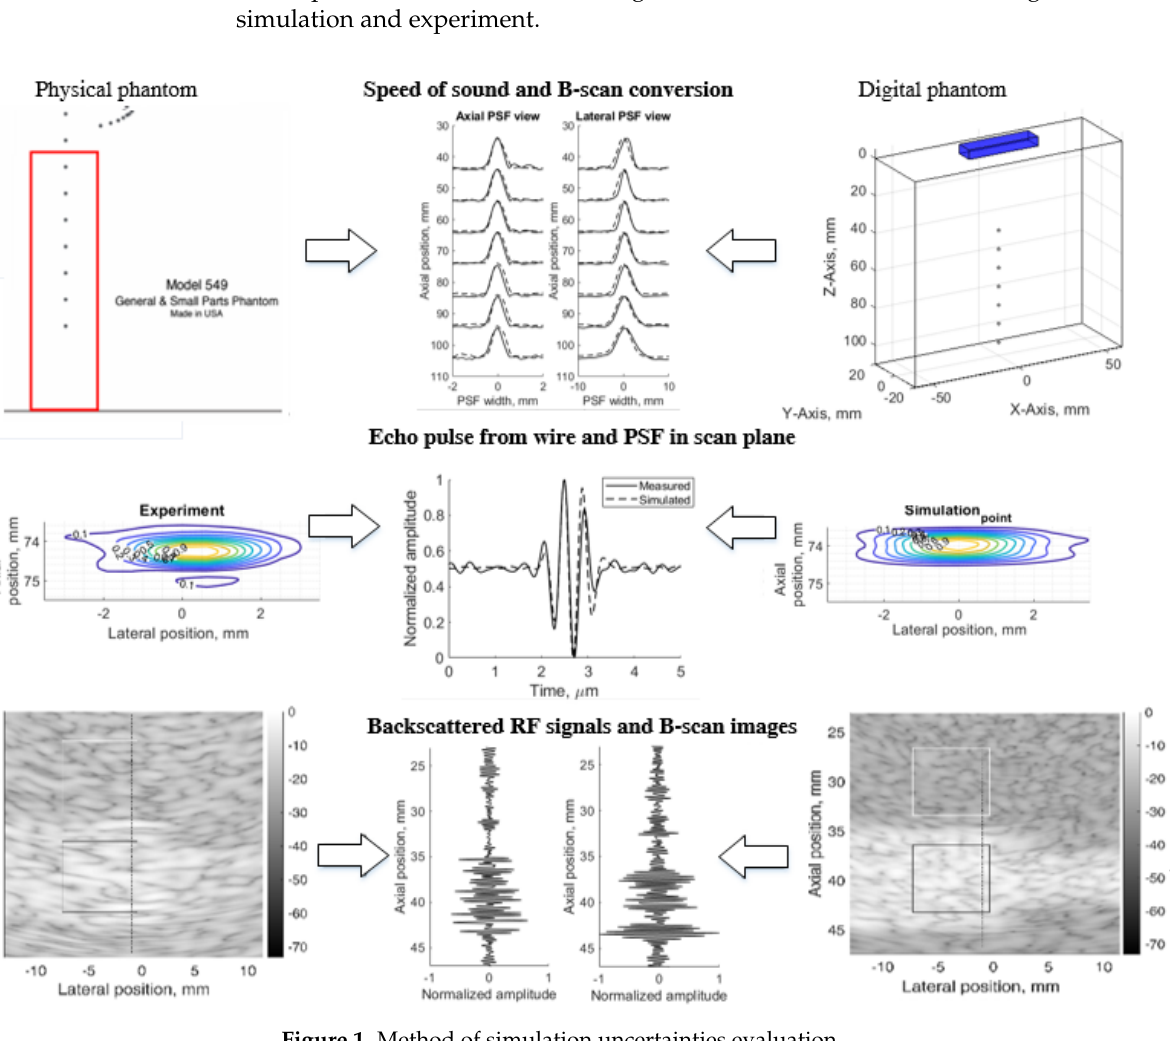
Figure 1. Method of simulation uncertainties evaluation.